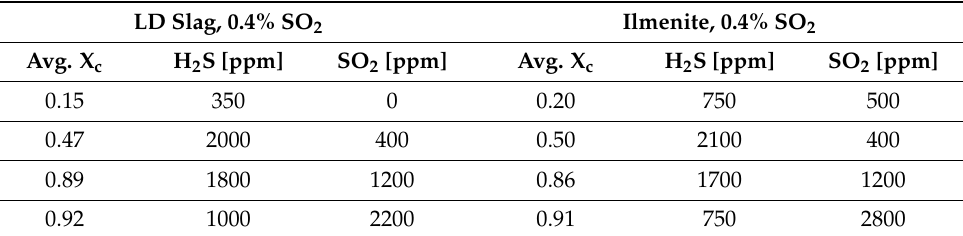
Table 6. Result of H 2 S and SO 2 concentrations from bag samples extracted during one cycle of gasification of German wood char in the presence of 0.4% SO 2 at 870 ◦ C. Roughly one liter of gas was extracted over 50–60 s, and the average X c was taken as the mean of the calculated X c for every bag sample during the extraction